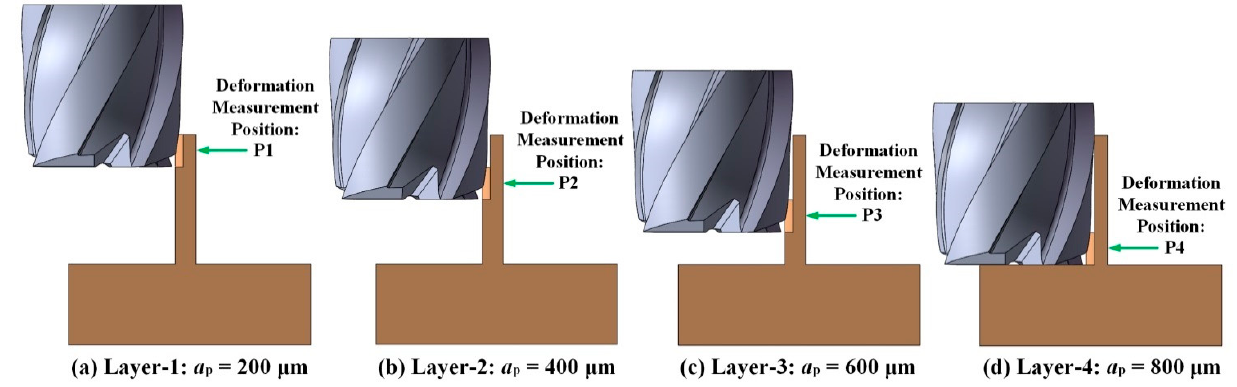
Figure 5. 3D model of micro milling cutter and thin wall workpiece.